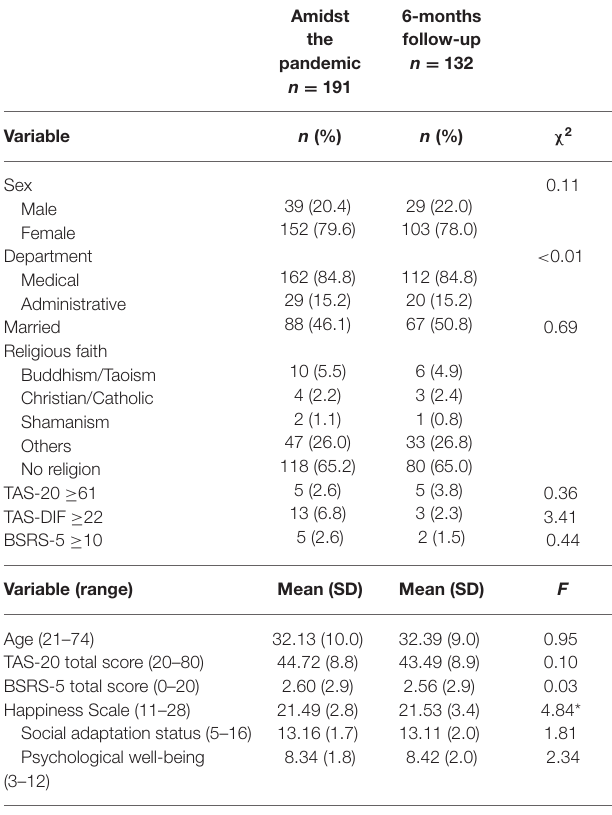
TABLE 1 | Socio-demographic and clinical characteristics of healthcare workers at baseline and 6-months follow-up ( N = 323). Amidst